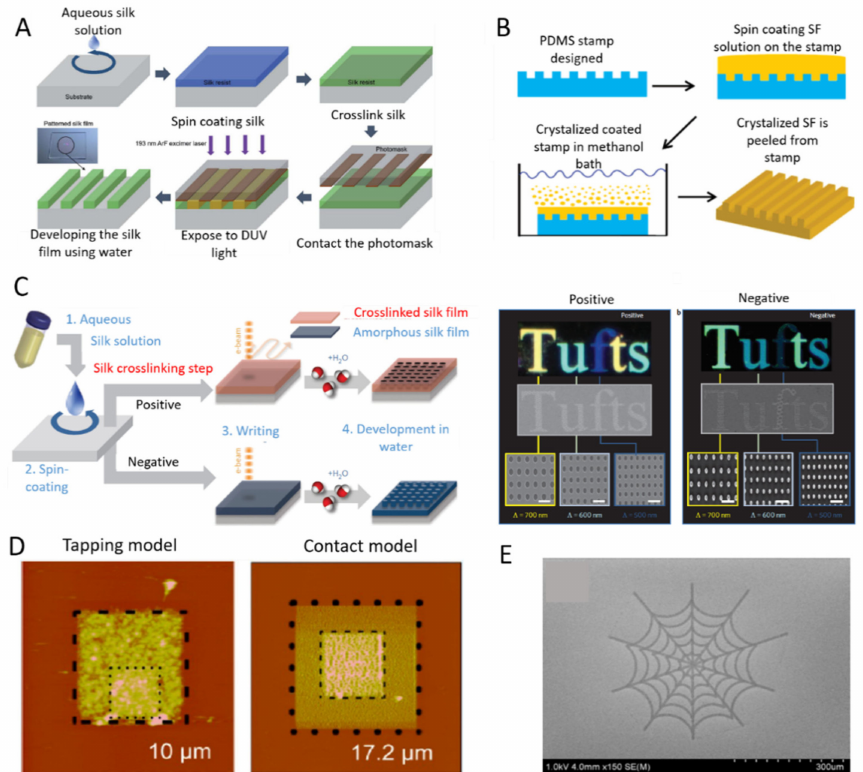
Figure 5. Micro-patterning of silk-based biomaterials. ( A ) Schematic diagram of ultraviolet lithog- raphy process which can form high-resolution silk fibroin micro-patterns by ArF (argon fluo- ride) excimer laser. ( B ) Schematic diagram of soft lithography of fabricating patterned silk films. ( C ) Schematic diagram of water-based electron-bean patterning on a silk film. Dark-field and electron microscopy images of silk nanostructures generated on positive and negative resist. ( D ) Atomic force microscopy (AFM) images of patterned silk films fabricated by AFM patterning in tapping mode and contact mode. ( E ) SEM images of micro-spider web fabricated by inkjet printing. Reprinted with permissions from